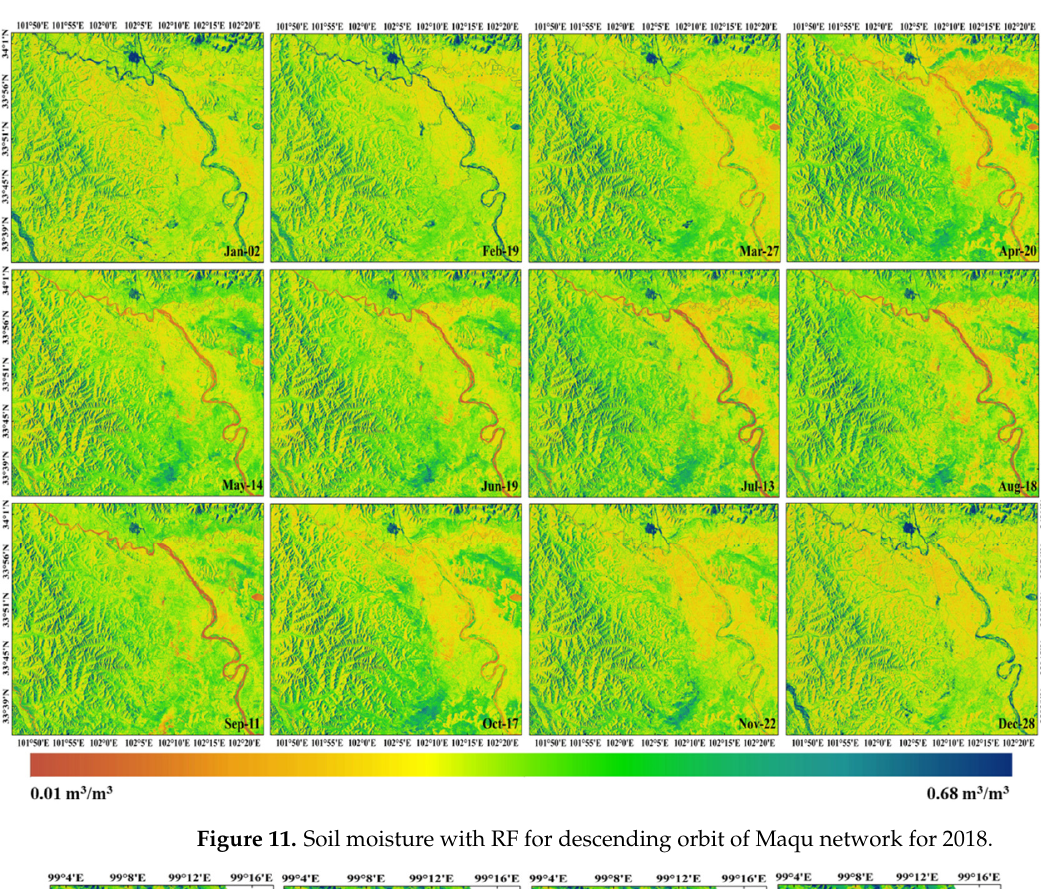
Figure 10. Soil moisture with RF for ascending orbit of Maqu network for 2018.